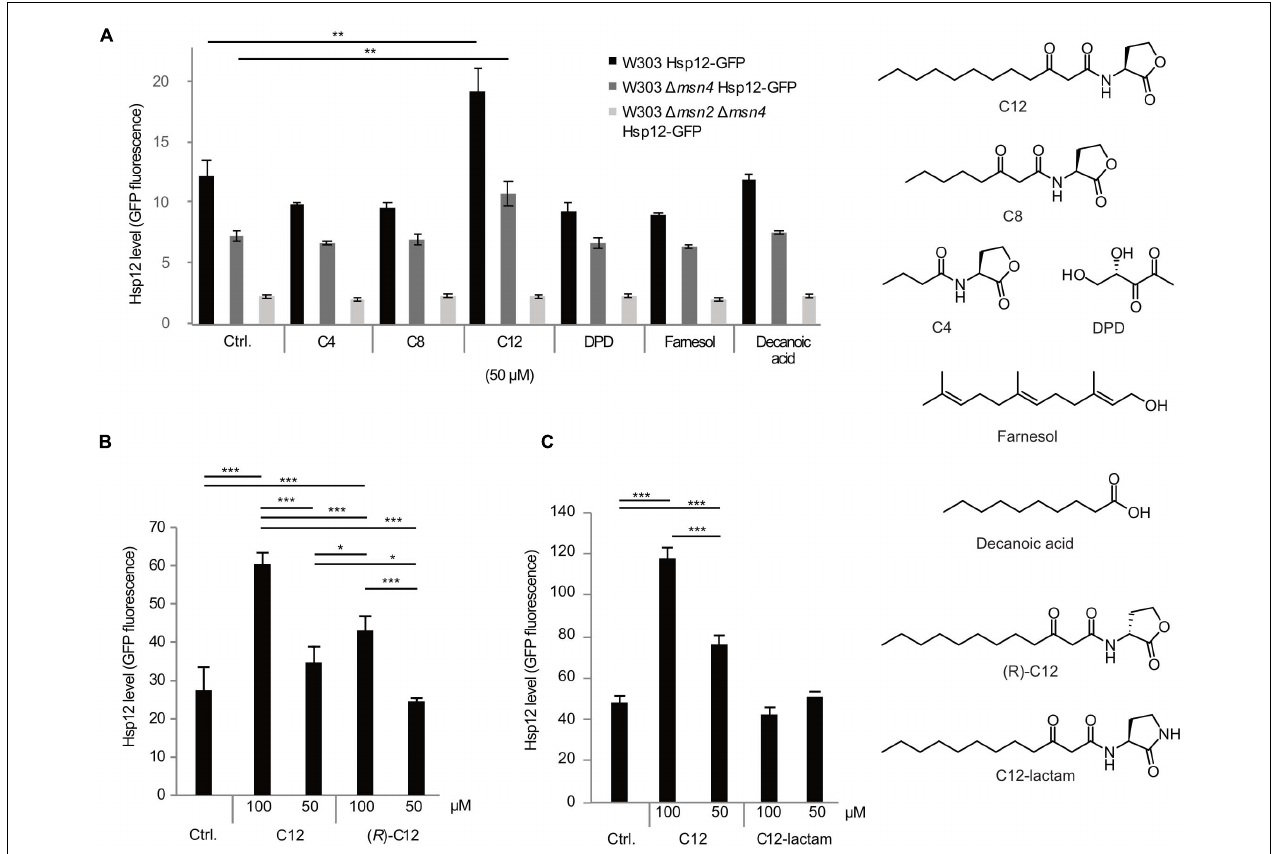
FIGURE 1 | Selective response of S. cerevisiae cells to different QSMs. Yeast cells (W303 WT, black bars, (cid:49) msn4 mutant, dark gray bars, and (cid:49) msn2 (cid:49) msn4 double mutant, light gray bars) were exposed to different QSMs for 45 min and the stress response measured by expression levels of GFP-labeled small heat shock protein Hsp12. (A) Initial screening for stress response to different QSMs and controls, tested at 50 µ M concentration: C12: 3-oxo-C12 HSL; C8: 3-oxo-C8 HSL; C4: C4 HSL; DPD: 4,5-dihydroxy-2,3 pentanedione; farnesol; decanoic acid. Ctrl. = solvent control (DMSO). C12 induced a significantly higher stress response than the control. Results are presented as the median of 10,000 cells for duplicate samples ( ± standard deviation) and are representative of other experiments. (B) Additional experiments were performed to determine the specificity of the response to C12. The stress response to C12 showed a concentration-dependent effect. The unnatural enantiomer of C12 induced a lower stress response than C12. (C) An additional control compound, C12-lactam, did not induce a significant stress response. For all panels, results are presented as the median of 10,000 cells for triplicate samples ( ± standard deviation) and are representative of other experiments. Significance of the variance between groups was calculated using a one-way ANOVA test, followed by pairwise comparisons using Tukey multiple comparison of means. Key: * p ≤ 0.05, ** p ≤ 0.01, *** p ≤